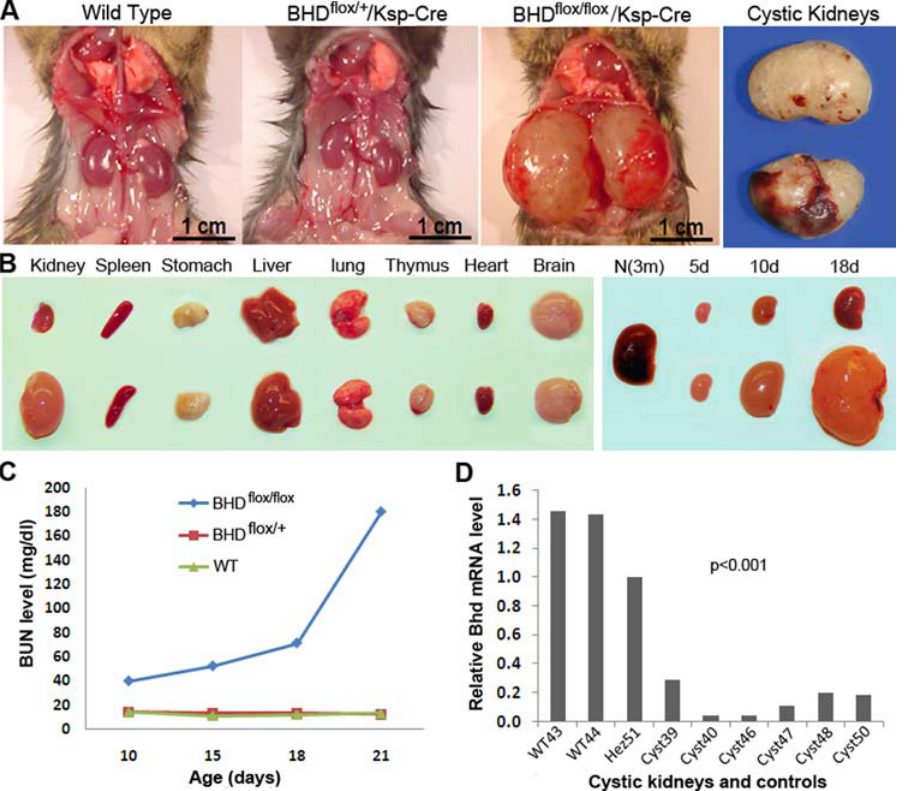
Figure 2. Phenotypes of BHD flox/flox /Ksp-Cre mice. (A) BHD flox/flox /Ksp-Cre mice developed polycystic kidney and died at age of three weeks. The kidneys from heterozygotes were phenotypically normal, similar to the ones from wild-type mice. (B) The organs from the affected mice were normal except for the kidneys (10 days old). There was not much size difference between the normal control kidneys and the affected kidneys at birth. However, the difference became apparent after the age of 5 days. At age of 10 days, the polycystic kidneys were approximate 15 times larger than those from normal controls. ( C ) Biochemical analysis revealed that the conditional knockout mice died of kidney failure due to high level of blood urea nitrogen (BUN). The BUN level dramatically elevated 15 days after birth. Most of the mice died at the age of 21 days. ( D ) The mRNA level of BHD in the kidneys of BHD flox/flox /Ksp-Cre mice is significantly lower than that in wild-type kidneys. The heterozygote also shows lower mRNA expression relative to the wild type. m=month; d=day. f/f=flox/flox; f/ + =flox/ +